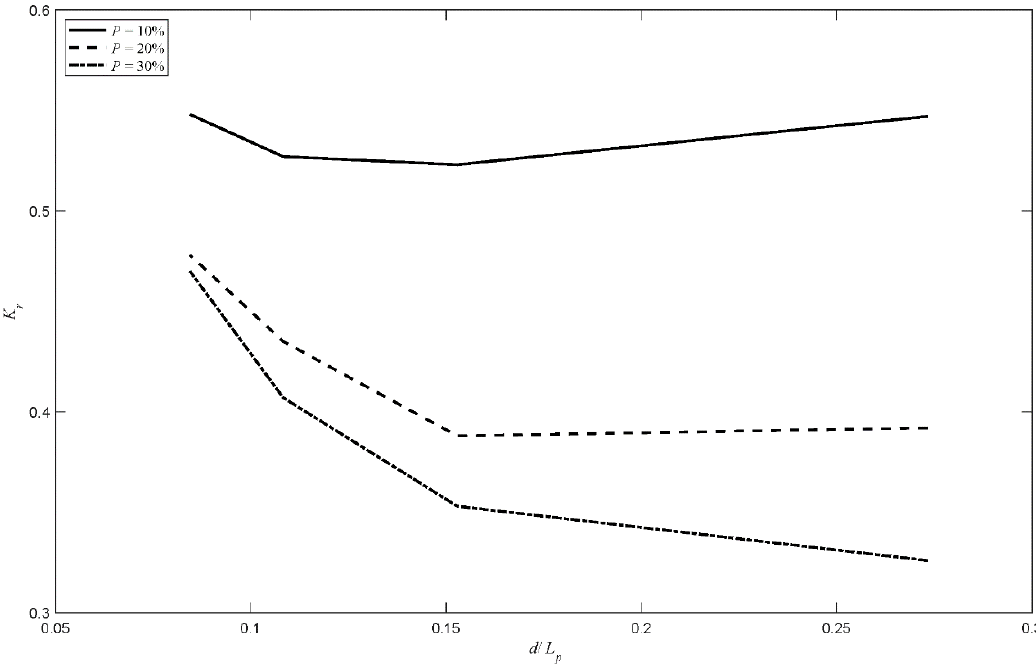
Figure 11. Effect of P on the variation of K r with d / L p . N = 1, θ = 90°, and H is / d = 0.1284. Figure 11. E ff ect of P on the variation of K r with d / L p . N = 1, θ = 90 ◦ , and H is / d =